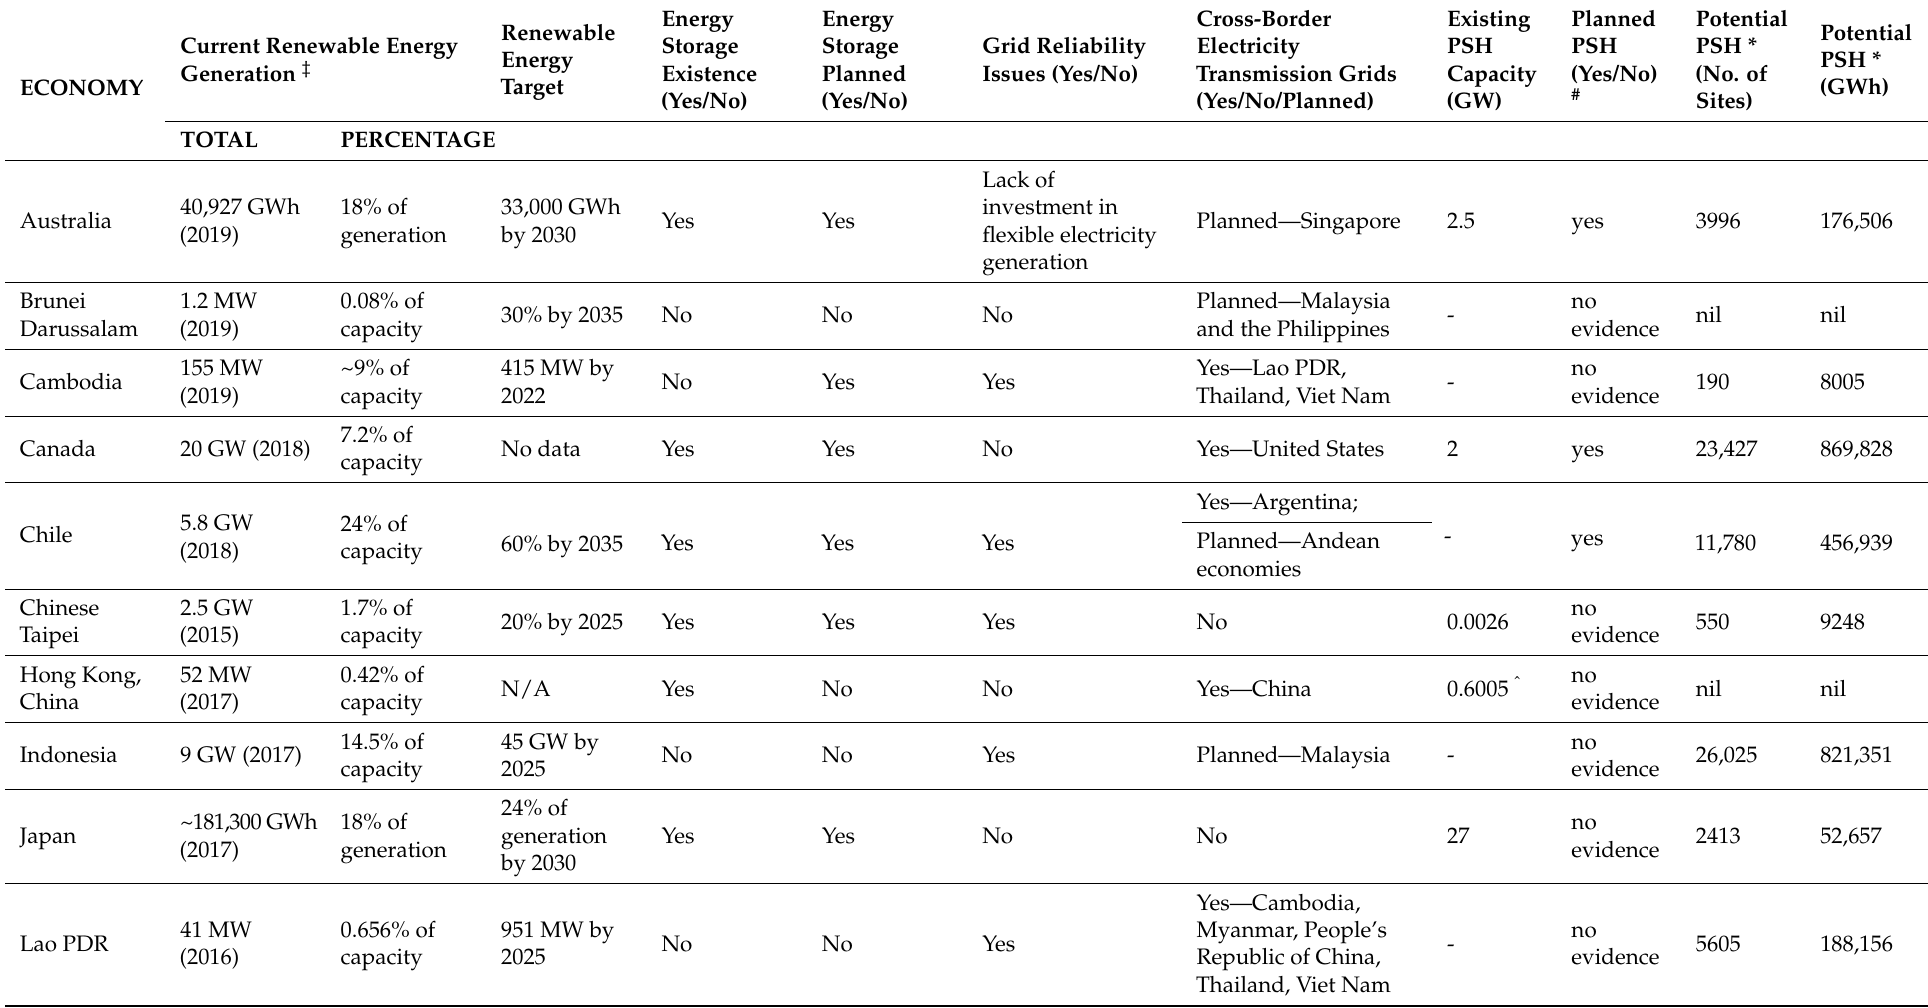
Table 1. Renewables-based generation, EES, status, and potential of PSH in target